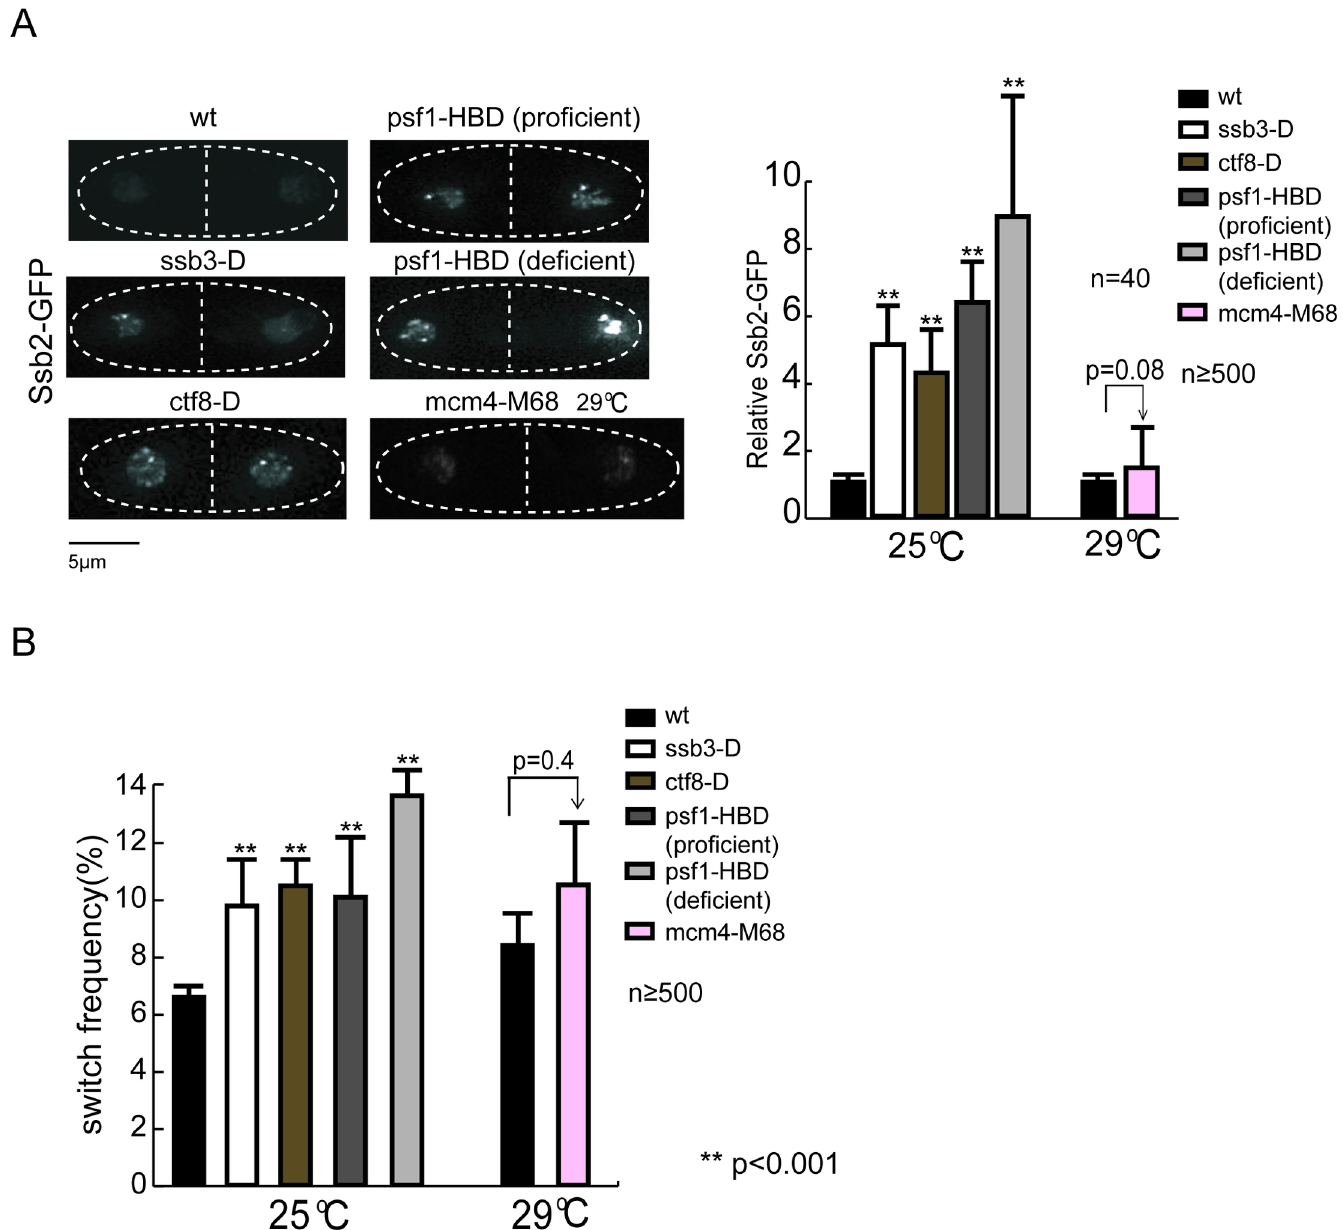
Fig 3. Mutations in the replication machinery enhance centromericPEV correlates with excessiveformation of ssDNA. (A) Increasedlevels of Ssb2-GFP signalin the mutant S phase cells. Cells are grown in the liquidrich media except for Psf1-HBD cells in YE+5S media plus 100nM β -estradiol (proficientcondition)or 0.1nM β -estradiol(deficient condition), respectively. mcm4-M68 cells are grown in 29 ˚ C for 6 hours. Ssb2-GFP signal is measured as in Fig 2A. Left panels,representative images of S phase cells. (B) Quantification of cnt2 :: ade6 + red-to-whiteswitching frequencyin the replication mutants. For psf1 -HBD (deficient) cells, pedigreeanalysesare performed on “hybrid” plates, on which three cell generationsare tracked at the “deficient”- zone containing0.1nM β -estradiol. The eight progenycells are then moved to the “proficient”-zone,containing 100nM β -estradiol, incubatedat 25 ˚ C for five days. For mcm4-M68 cells, pedigreeanalysisis performed at 29 ˚ C, and incubatedat 25 ˚ C for 5 days before scoring. For each test, 500–800cell division events are scored. The error bars are 1 SD of percentages for four independent experiments. p values are calculatedby t test. https://doi.org/10.1371/journal.pgen.1006900.g003 PLOS Genetics | https://doi.org/10.1371/journal.pgen.1006900 July 27,